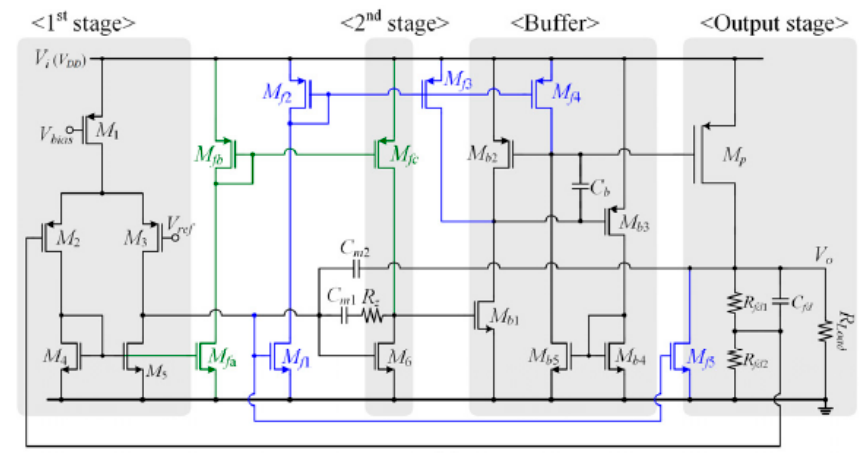
Figure 20. Low-VDD Inverting Buffer-based ALDO [48].